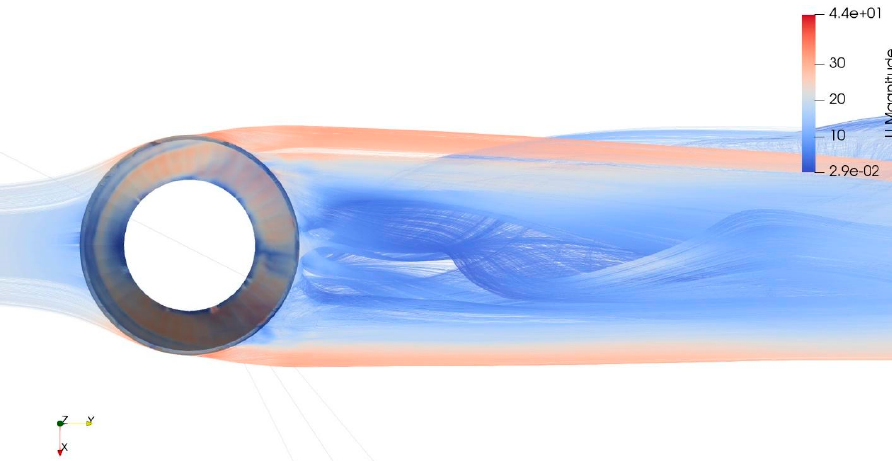
Figure 6. Top view of streamlines colored by magnitude of velocity. The air only travels through third and fourth fin of the tube and develops along the control volume to improve visibility.